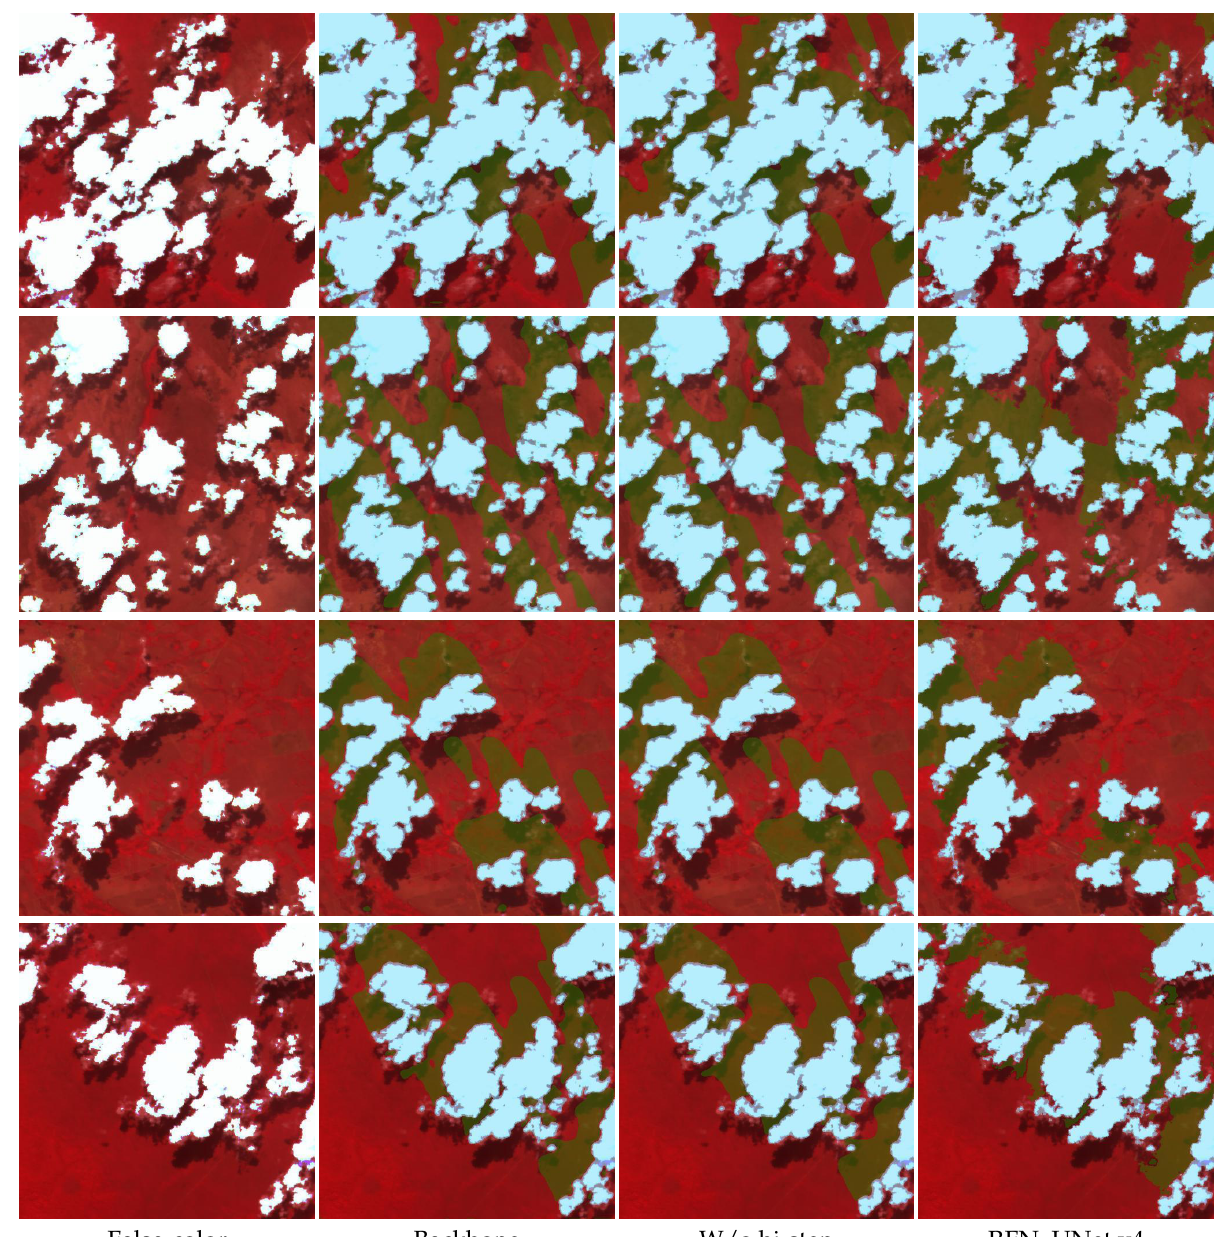
Figure 6. Illustrations of the effects of the critical modules (1). The typical patches are drawn from GF1WFV1.16m.2014267223114.21LTD.FAGUO1.SR.tiff. It is observed that the proposals given by the backbone and the full model without the bilateral manipulation are visually close but those given by the full model are significantly refined on the edges. Such results confirm that the bilateral manipulation within the CRF module is critical to edge